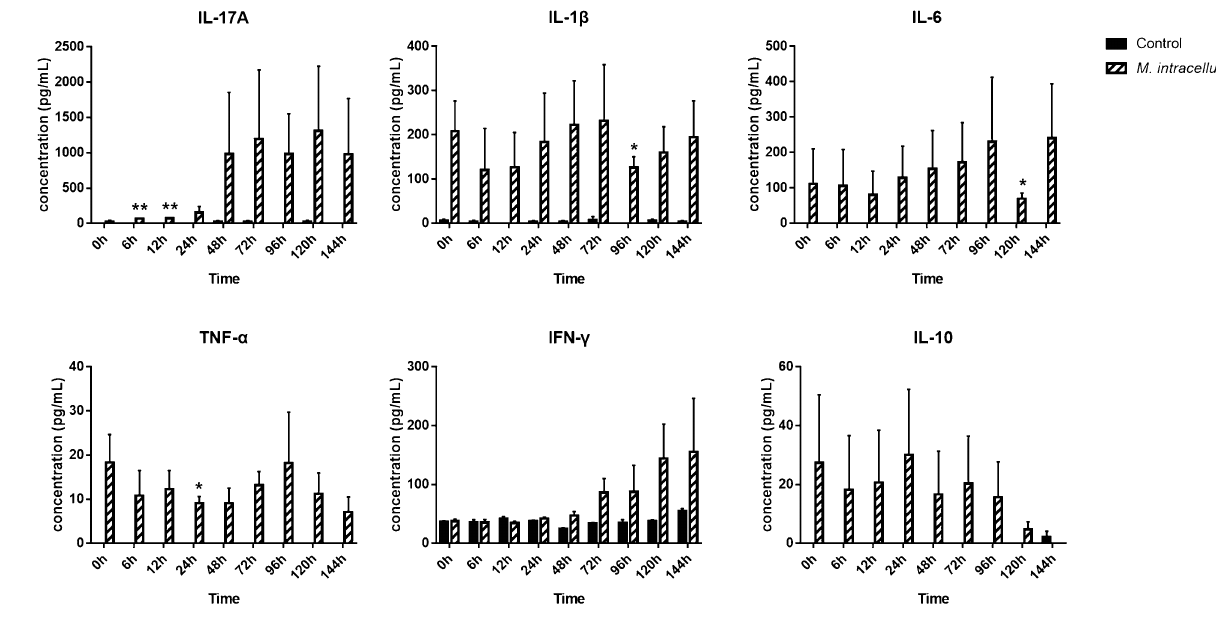
Figure 5. Cytokine expression in canine monocyte-depleted PBMCs co-cultured with canine MDMs after M. intracellulare infection. The concentration of IL-17A, IL-1β, IL-6, TNF-α, IL-12, IFN-γ, IL-10, and IL-4 was determined by ELISA. IL-4 and IL-12 were not detected. Cytokine expression in noninfected cells at each time point was used as a control. Each bar represents the mean ± SEM from three independent experiments in individual dogs. * p < 0.05, ** p < 0.01.